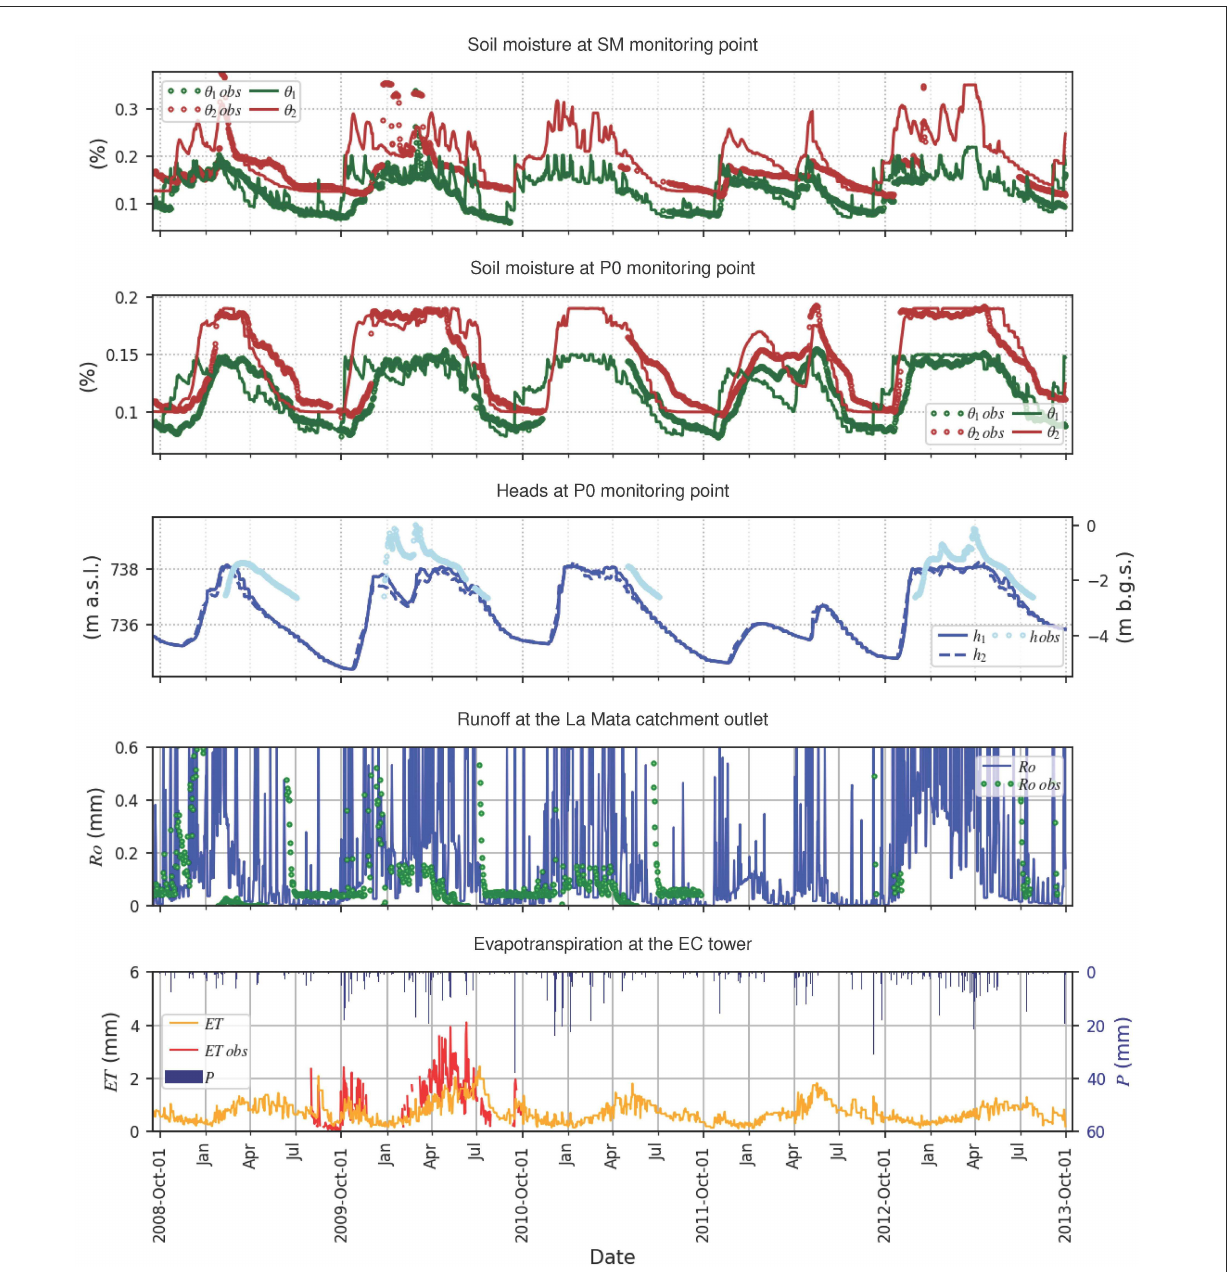
FIGURE6 Calibration plots. Locations of SM, P0, La Mata catchment outlet and EC tower as in Figure 1. θ n obs , observed soil moisture in the field; θ n , simulated soil moisture; n , soil layer index varying between 1 and the total number of soil layers (in this case 2); h obs , observed hydraulic head; h l , simulated hydraulic head; l , MF layer index varying between 1 and the total number of MF layers (in this case 2); m a.s.l., meters above sea level; m b.g.s., meters below ground surface; Ro obs , runoff measured at the Sardón catchment outlet ( < 145 L.s − 1 , measured by flume) and corrected using the area